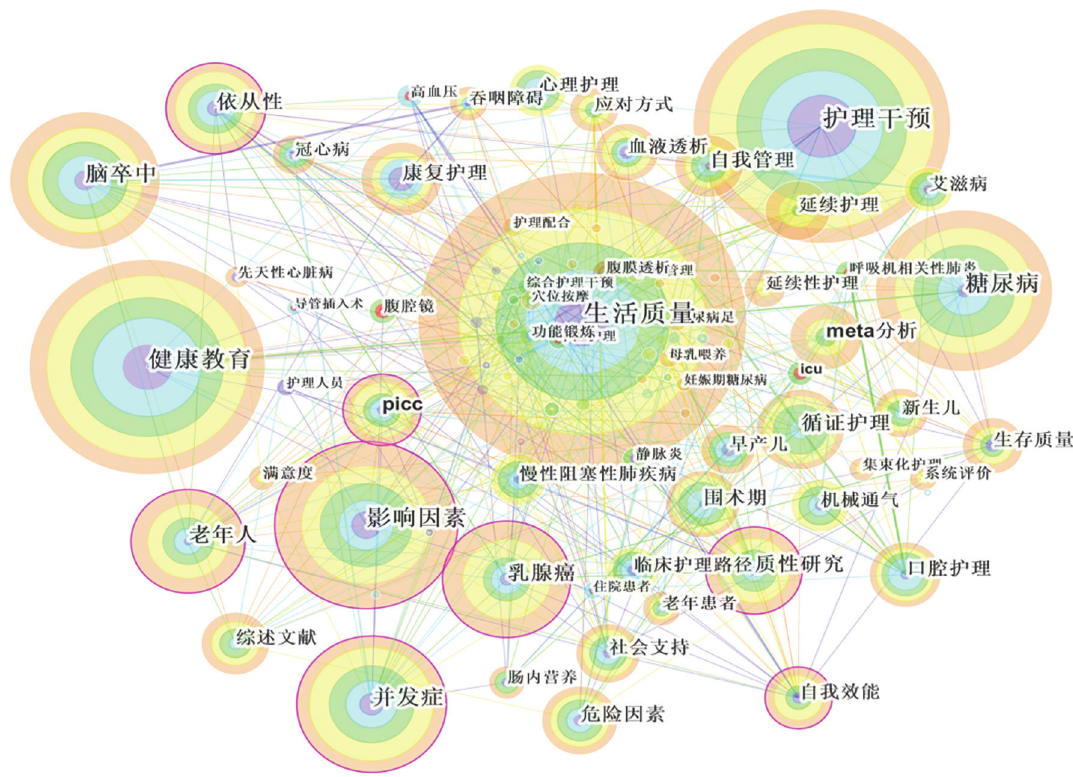
Figure 3. Co-occurrence mapping knowledge domains